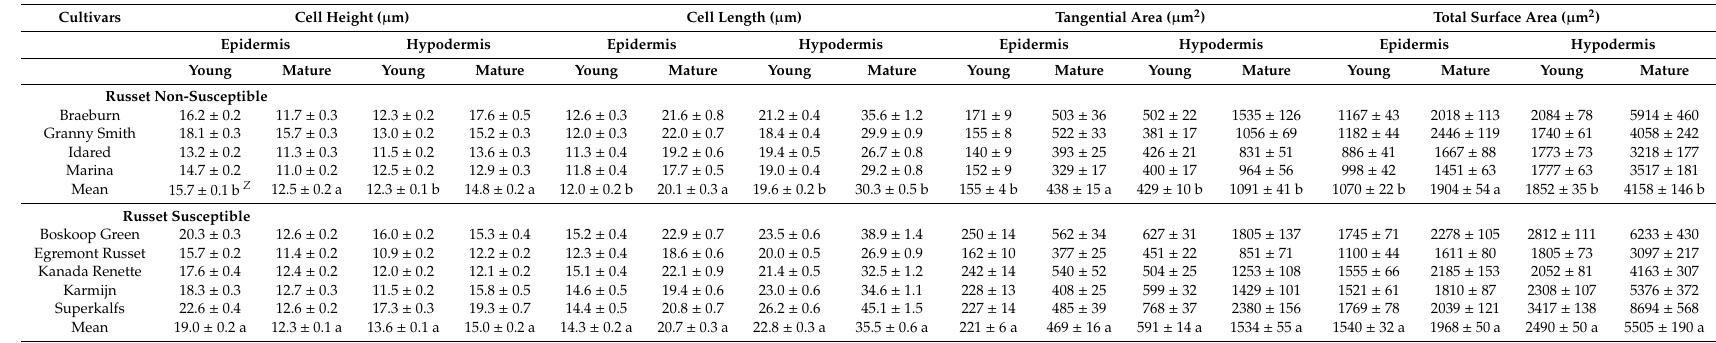
Table 2. Epidermal and hypodermal cell parameters of young (28–35 days after full bloom) and mature fruit of selected russet non-susceptible and russet-susceptible apple cultivars. Results for ‘Idared’ and ‘Karmijn’ were taken from the Figure 3. Data in the table represent means ± SE. The numbers of cells measured were 68–145 (epidermis) and 172–331 (hypodermis) cells in young and 57–97 (epidermis) and 128–205 (hypodermis) cells in mature fruit. Cells were measured in seven fruit per